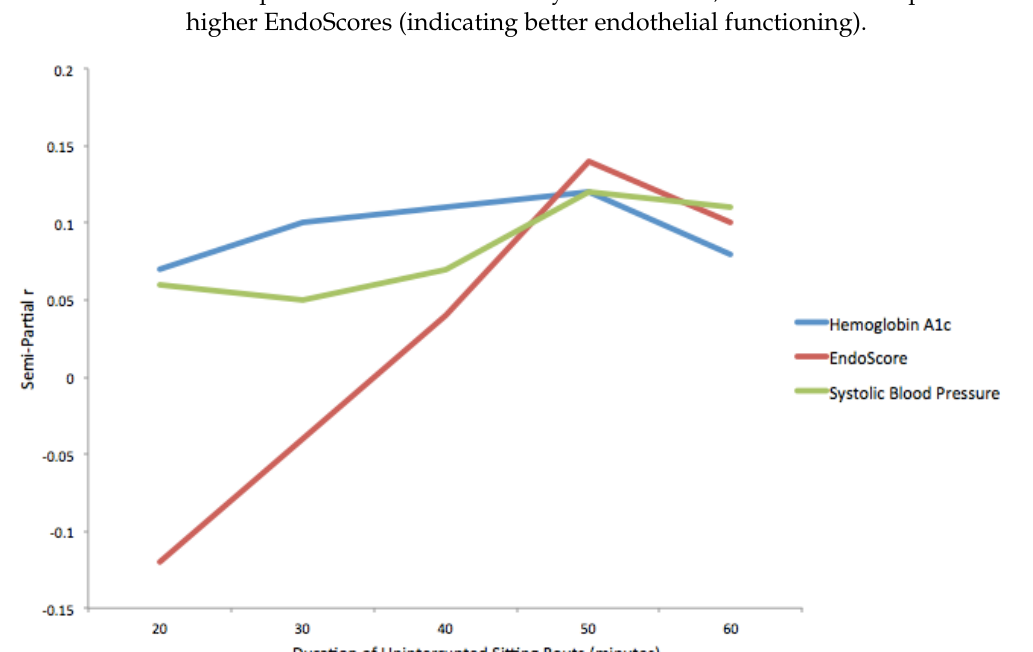
Figure 2. Semi-partial correlation coefficients for relationships between physiological markers and uninterrupted sitting bouts. Table 3. Regression Coefficients for Frequency of Uninterrupted Sitting Bouts and Physiological Markers, Controlling for Physical